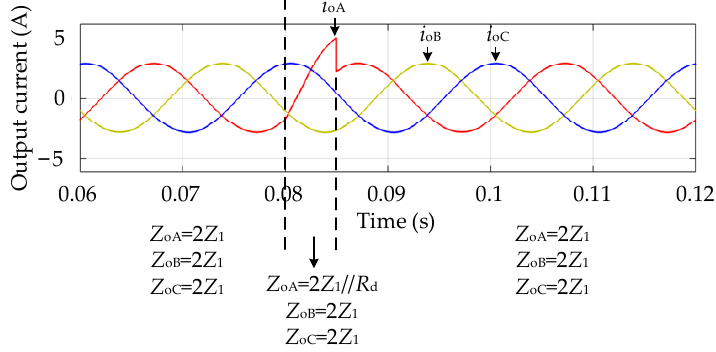
Figure 15. The output current of each phase when the disturbance load was added to the A-phase.